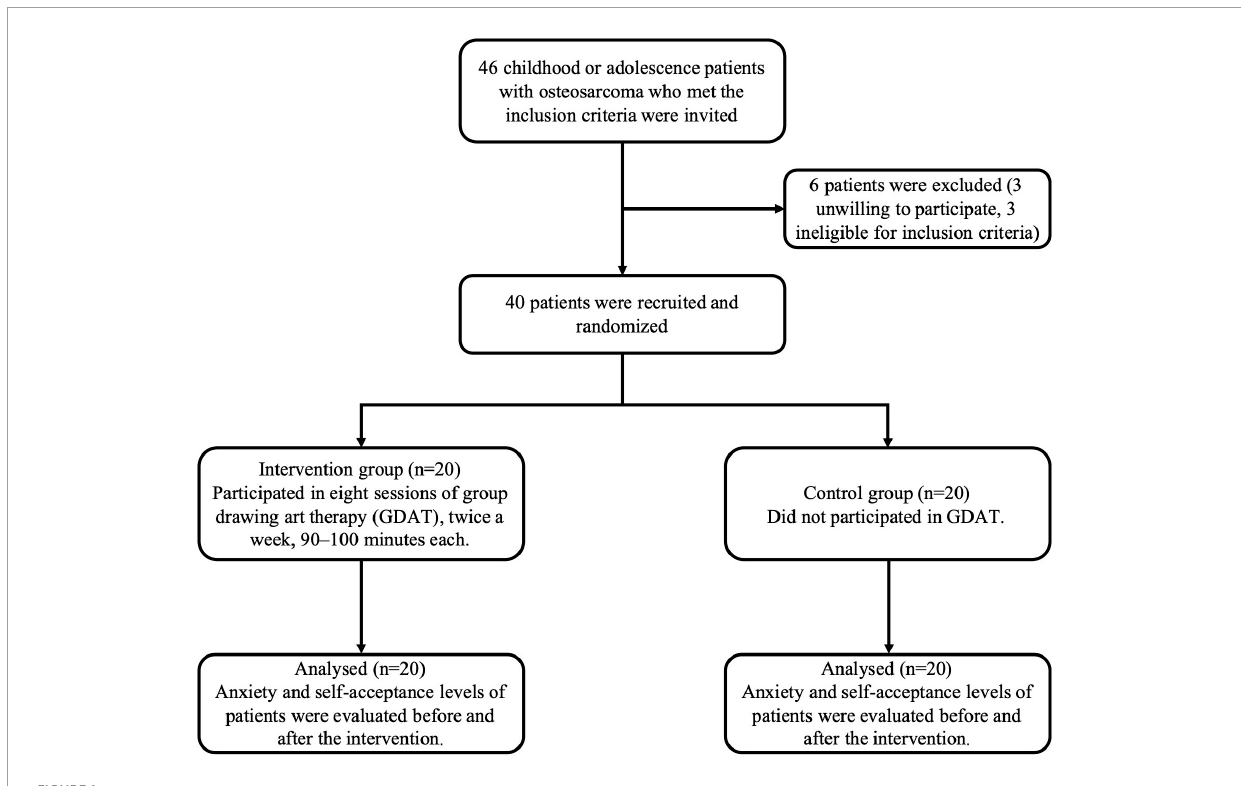
FIGURE1 The consort diagram of the participants of this